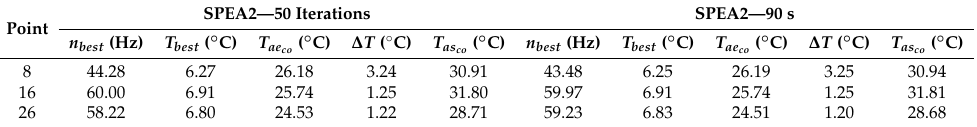
Table 5. Verification of compliance of SPEA2 with the operational restrictions of the equipment for the 3 operational